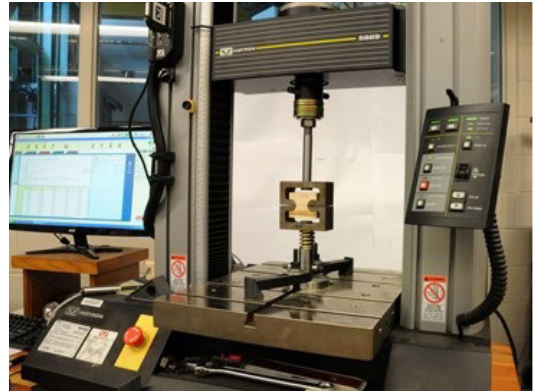
Figure 4. Tension perpendicular to grain loading